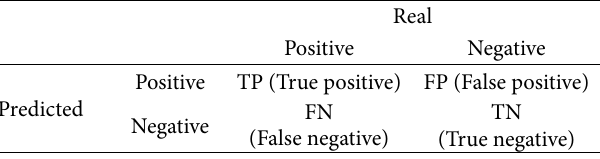
+Edges denote the positive edges in networks. Table 3: The parameters used to calculate metrics.